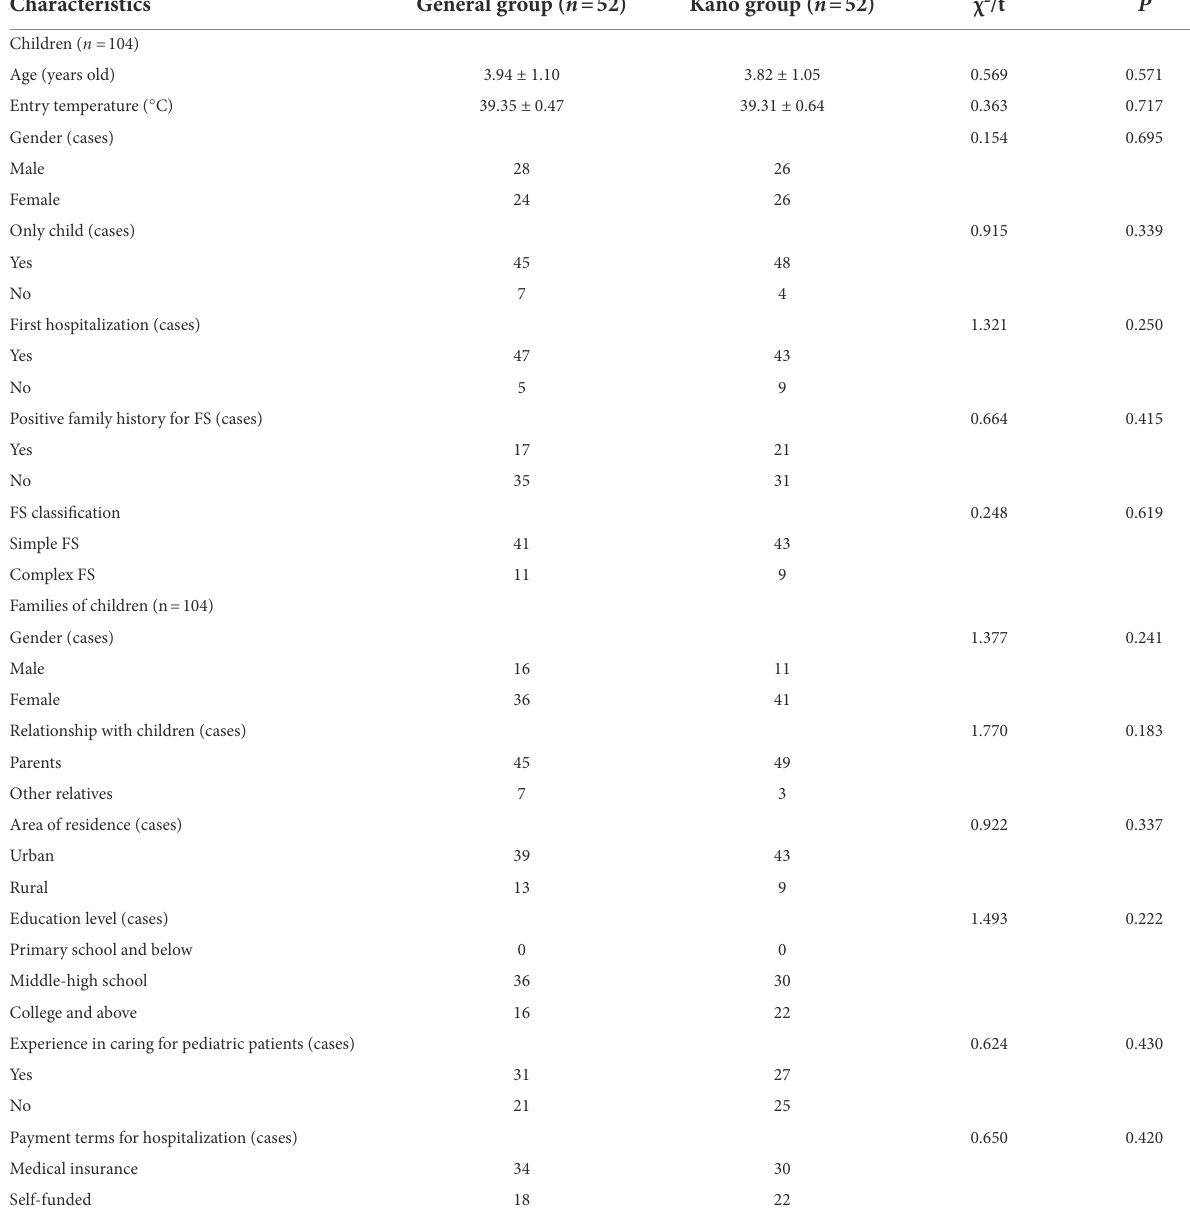
TABLE 1 Comparison of general characteristics of children and their families in the general group and Kano group.